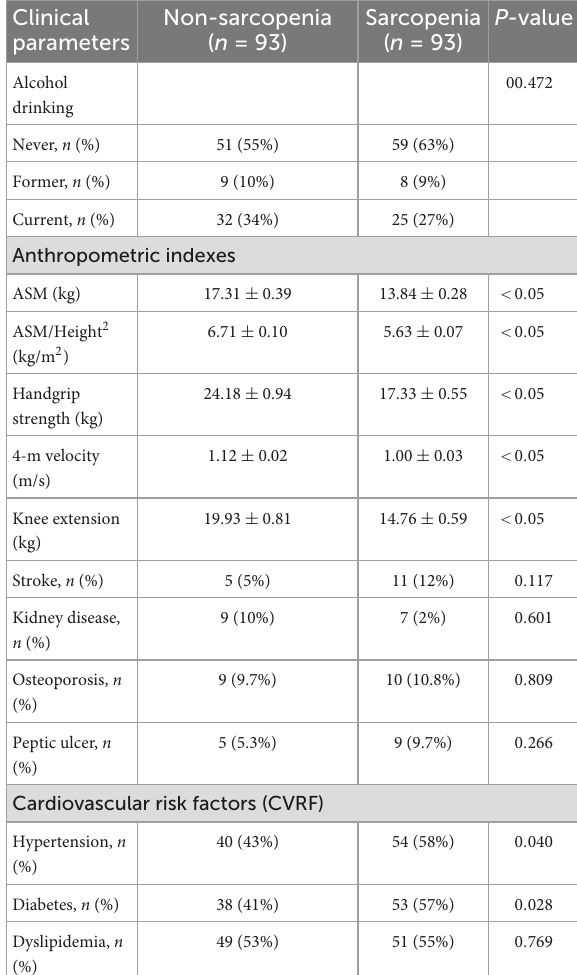
TABLE 1 Clinical and anthropometric characteristics of study subjects according to the presence of